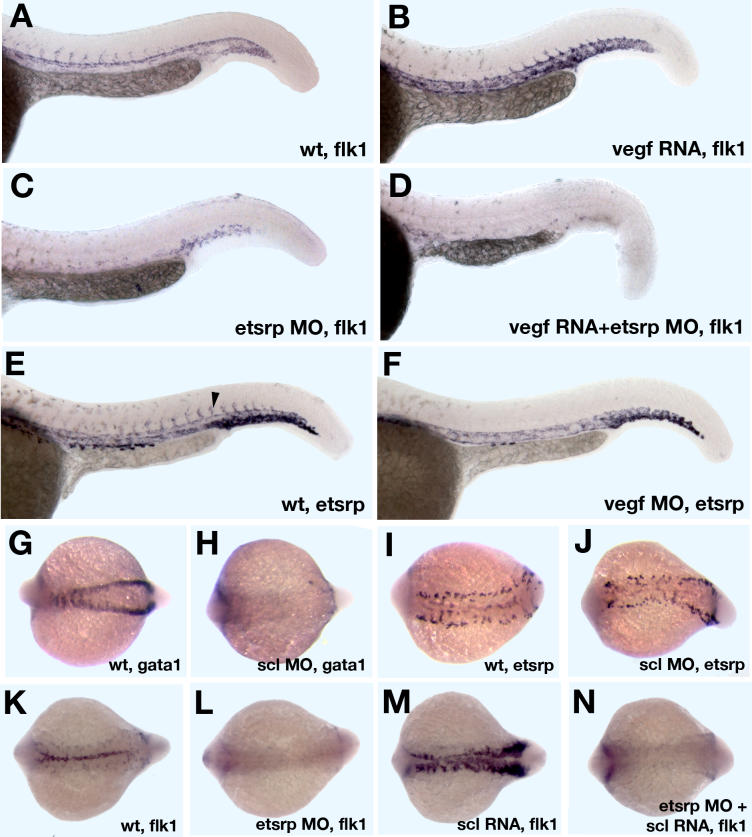
etsrp Is Required for vegf and scl Signaling(A–D) Etsrp is required for Vegf signaling as assayed for flk1 expression at 26 hpf. (A) Control uninjected embryo, (B) vegf RNA-injected embryo, (C) 7.5 ng of etsrp MO2-injected embryo, (D) vegf RNA- and etsrp MO2-co-injected embryo. Note that vegf RNA induces strong flk1 expression in (B) while vegf RNA and etsrp MO co-injection results in loss of flk1 expression in (D), similar to the etsrp morphant phenotype in (C). (E,F) Etsrp expression analysis in Vegf morphants at 26 hpf. (E) Control uninjected embryo; (F) 10.5 ng of vegf MO-injected embryo. Note that vegf morphants have lost etsrp expression in the intersegmental vessels (arrowhead, E). (G–J) Scl knockdown affects gata1 but not etsrp expression at the 15-somite stage. Dorsal view, anterior is to the left. (G,I) Control uninjected embryo; (H,J) 10 ng scl UTR-MO-injected embryo. (G,H) gata1 expression; (I,J) etsrp expression. (K–N) Etsrp is required for scl signaling in clo mutants as analyzed for flk1 expression at the 15-somite stage. (K) Control uninjected embryo; (L) 7.5 ng etsrp MO2-injected embryo; (M) scl RNA-injected embryo; (N) scl RNA- and etsrp MO2-co-injected embryo. Note that scl RNA causes ectopic flk1 expression in (M) which is lost upon knockdown of Etsrp in (N).